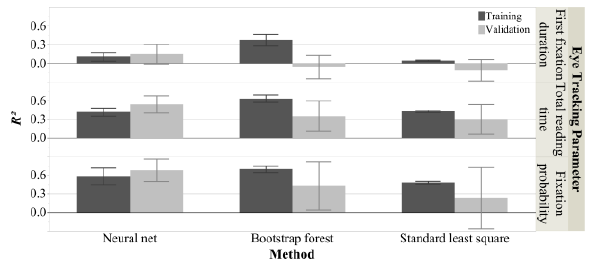
Figure 2 . Model Fits of Different Measure Groups via Dif- ferent Modeling Methods. This figure shows the mean R 2 s from 1000 iterations for three eye tracking parameters for both the training and validation sets using all three modeling ap- proaches. Each error bar is constructed using 1 standard devia- tion from the mean.